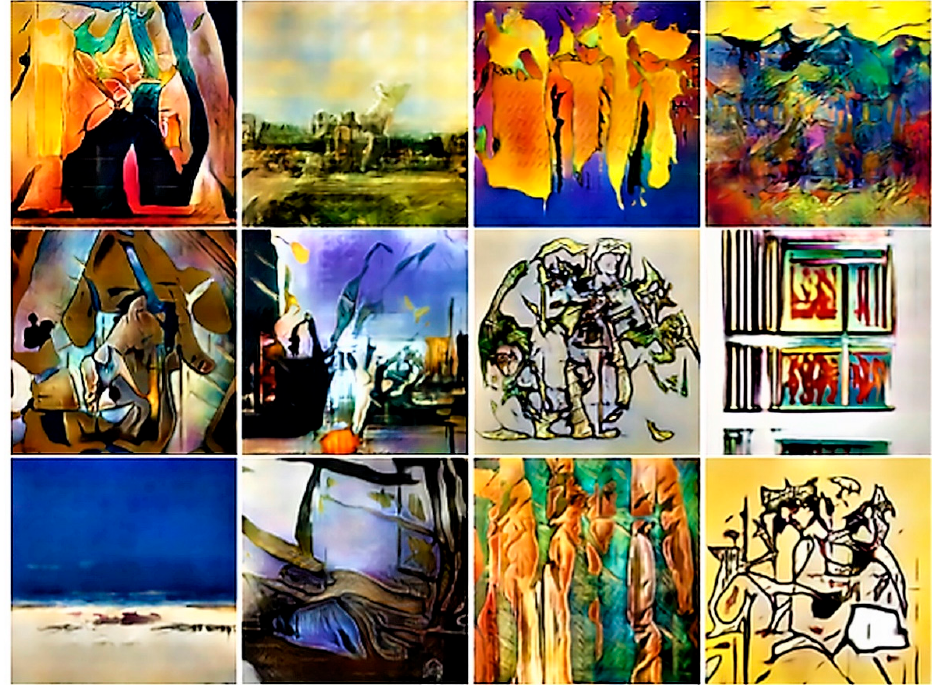
Figure 16. Images generated by the CAN that were ranked as the most realistic and unique by human subjects.